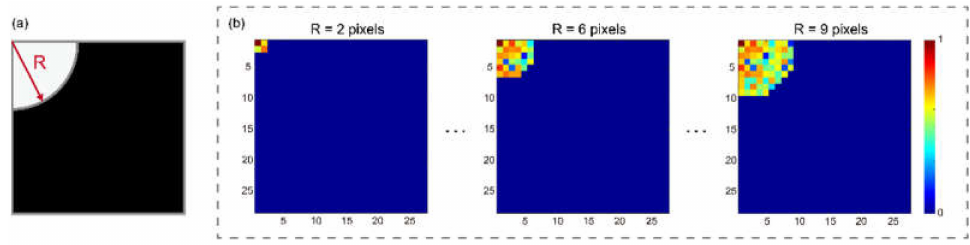
Figure 3. Selection of DST coefficients: ( a ) a quadrant mask to select low-frequency coefficients and ( b ) selected low-frequency